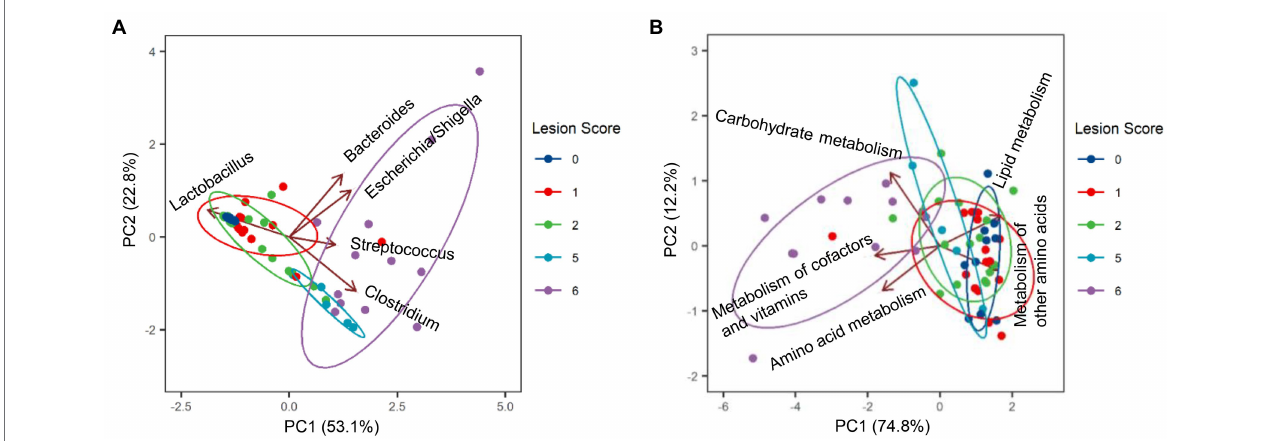
FIGURE 6 | Biplots of principal component analysis showing relative contributions of top five genera (A) and top five predicted Kyoto Encyclopedia of Genes and Genomes (KEGG) pathways (B) to the divergence of the ileal microbiota in response to NE. Each biplot line shows the direction of the change, with the length of each line indicating the degree of correlation with ordination